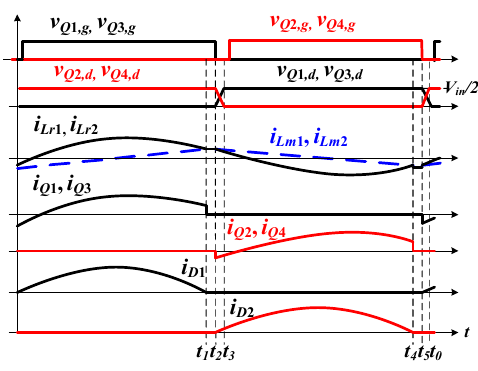
Figure 4. Basic circuit waveforms of the studied cascade resonant dc–dc converter.